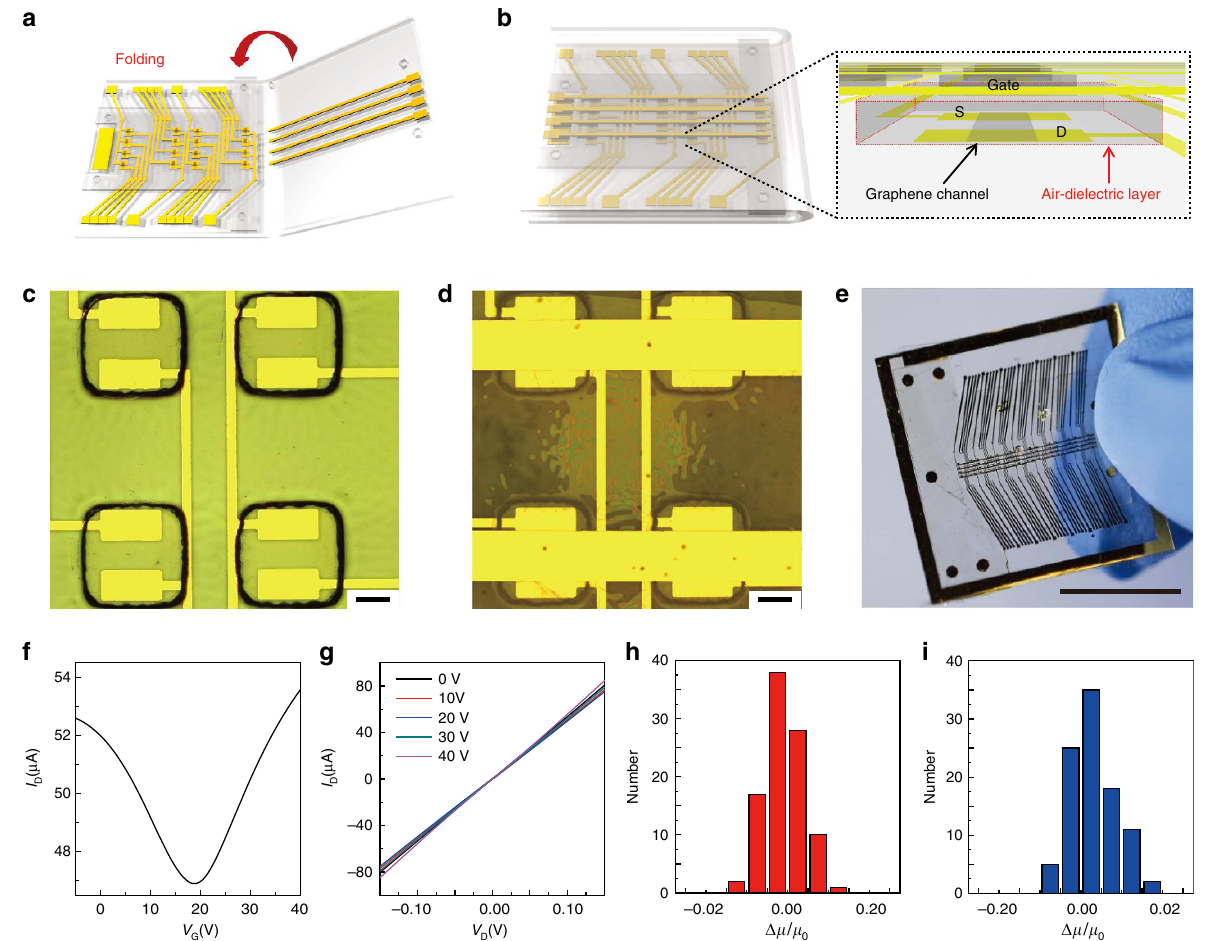
Figure 1 | Pressure-sensitive graphene FETs with air-dielectric layers. ( a , b ) Schematic images of pressure-sensitive graphene FETs with air-dielectric layers before ( a ) and after ( b ) the folding, respectively. The air-dielectric layer is placed between the graphene channel and the gate electrode as illustrated in the schematic image (inset). ( c , d ) Optical microscopy image for graphene FETs with air-dielectric layer surrounded by p-PDMS supporting walls. Scale bars, 200 m m. ( c ) Source, drain electrodes and graphene channel are shown. Black squares are the p-PDMS supporting walls that form the air-dielectric layer. ( d ) Top gate electrodes cover the air-dielectric holes by substrate folding. ( e ) Photograph of the fabricated pressure-sensitive graphene FETs, Scale bar, 1cm. ( f ) Transfer characteristics ( V D ¼ 0.1V). ( g ) Output characteristics ( V G ¼ 0–40V). ( h , i ) Statistical distribution of the relative change in the field effect mobility of the p-type ( h ) and n-type ( i )